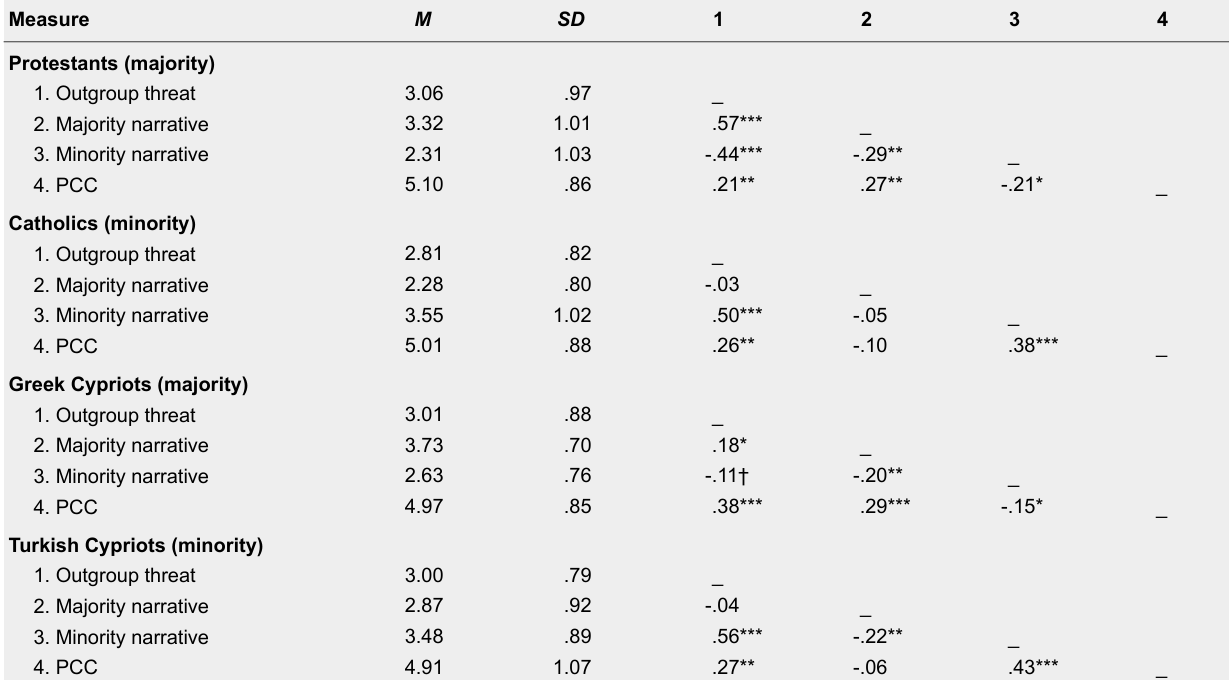
Means, standard deviations and bivariate correlations between all measures seperately for the communities in Northern Ireland (Protestants & Catholics) and Cyprus (Turkish and Greek